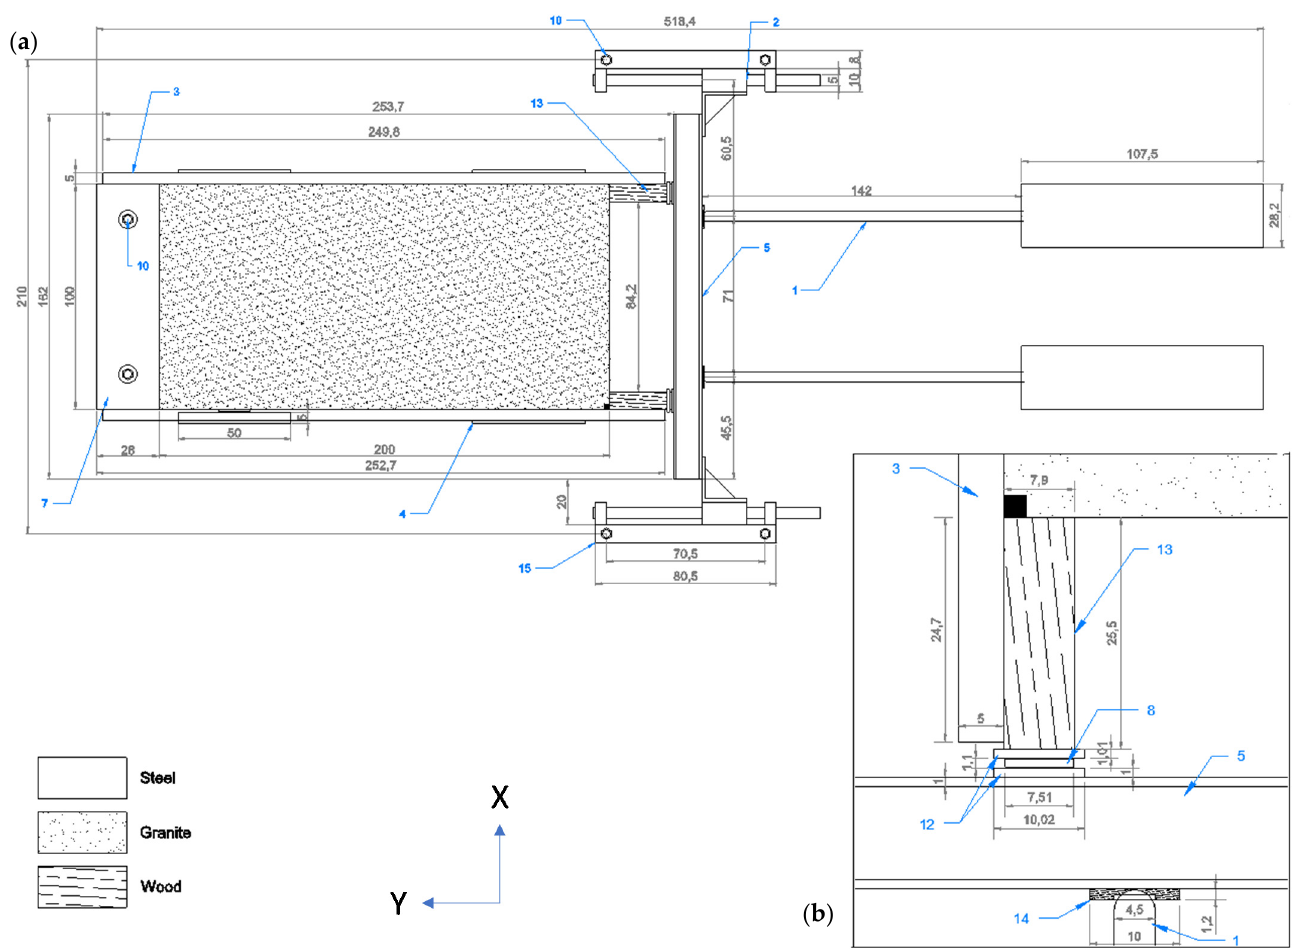
Figure A2. ( a ) Top view of the experimental setup. ( b ) Close-up of contact mechanism between the hydraulic cylinders and the rock slab. Dimensions in centimeters [cm]. 1—Hydraulic cylinders; 2—Actuators; 3—Steel beams—frame; 4—Steel beams—lateral restriction; 5—Steel beam—H-beam (force transfer); 6—Bolts; 7—Barrier; 8—Ball plates; 9—Wooden pallet; 10—Floor anchors; 11—Steel clamps; 12—Steel plates; 13—Wooden blocks—force transfer; 14—Wooden plate—centralizer; 15—Steel support—HSS profile.